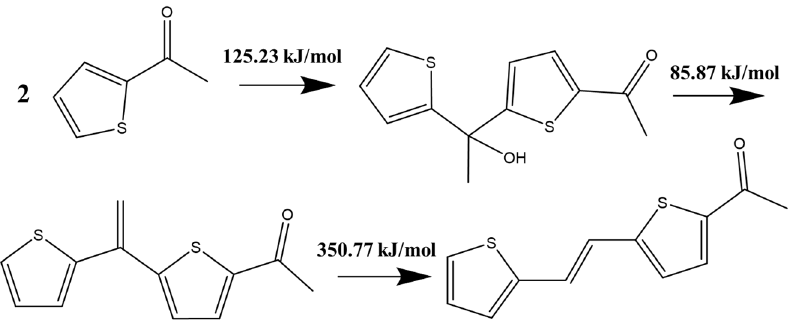
Scheme 4. The mechanism of product dimerization with H + and AC.